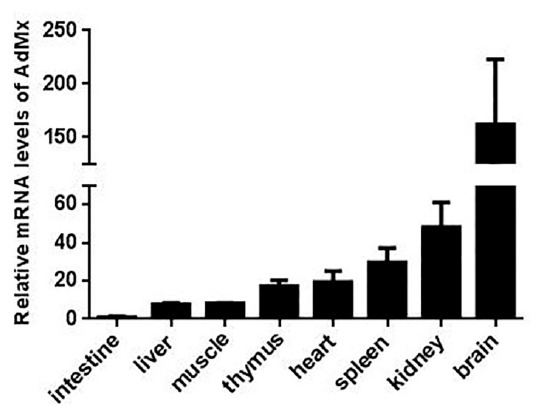
Figure 4. The mRNA expression pattern of AdMx in healthy Chinese giant salamander tissues. AdMx expression in the intestine, liver, muscle, thymus, heart, spleen, kidney and brain was determined by quantitative real time PCR (qRT-PCR) and all data were normalized to β -actin. For convenience of comparison, the expression level in the intestine was set as 1. Error bars indicate the mean ± SD ( n = 3).